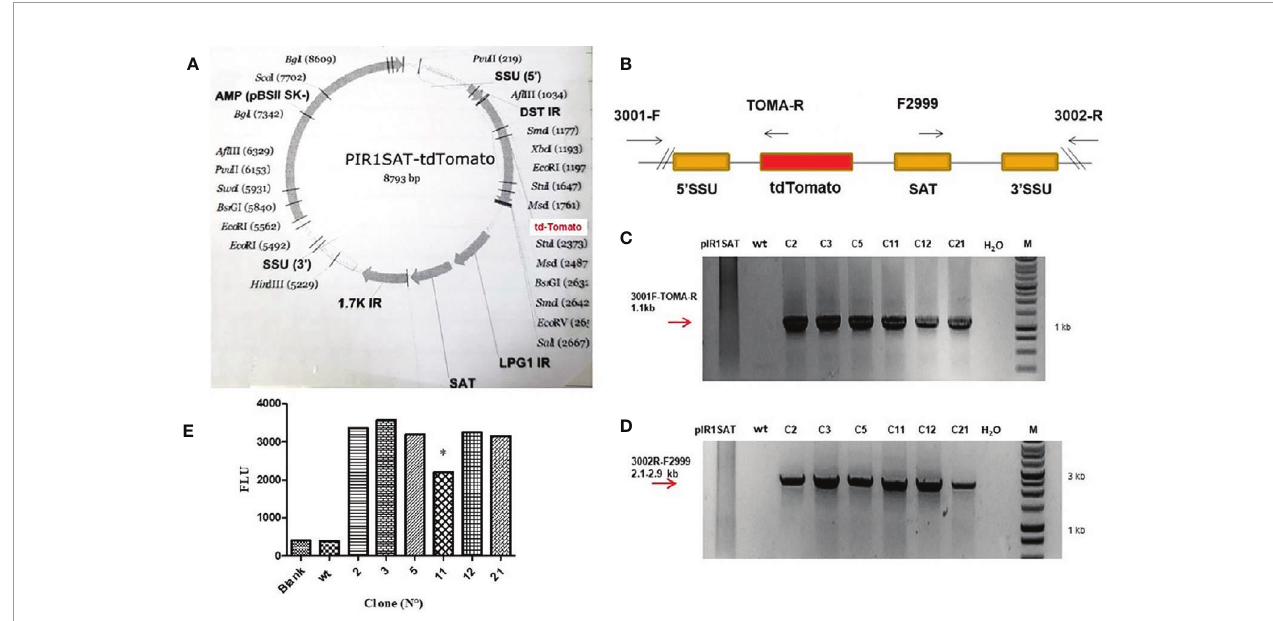
FIGURE 1 | (A) Map of the PIR1SAT-tdTomato plasmid indicating the enzyme used for cloning and linearization for L. (L.) amazonensis transfection assays. (B) Schematic representation of expected genomic loci of transfected Leishmania after replacement of one copy of the SSU rRNA gene. (C) PCR genotyping analysis with primers 3001-F/TOMA-R con fi rming the expected gene insertion. (D) PCR genotyping analysis with primers 3002-R/F2999 also corroborating the correct insertion and replacement of SSU rRNA gene. Line 1: pIR1SAT-tdTomato plasmid, line 2: wild type parasites, lines 3-8: transfected clones, line 9: no template control (-), line 10: molecular weight and marker. Diagrams are not to scale. Numbers are sizes (kb) of expected products. (E) Detection of fl uorescence emission in six clone selected (C2, C3, C5, C11, C12 and C21) after 24 h of incubation at 23°C (* p < 0.05). Parasite wild-type (wt). Statistical signi fi cance was assessed using ANOVA (* p <